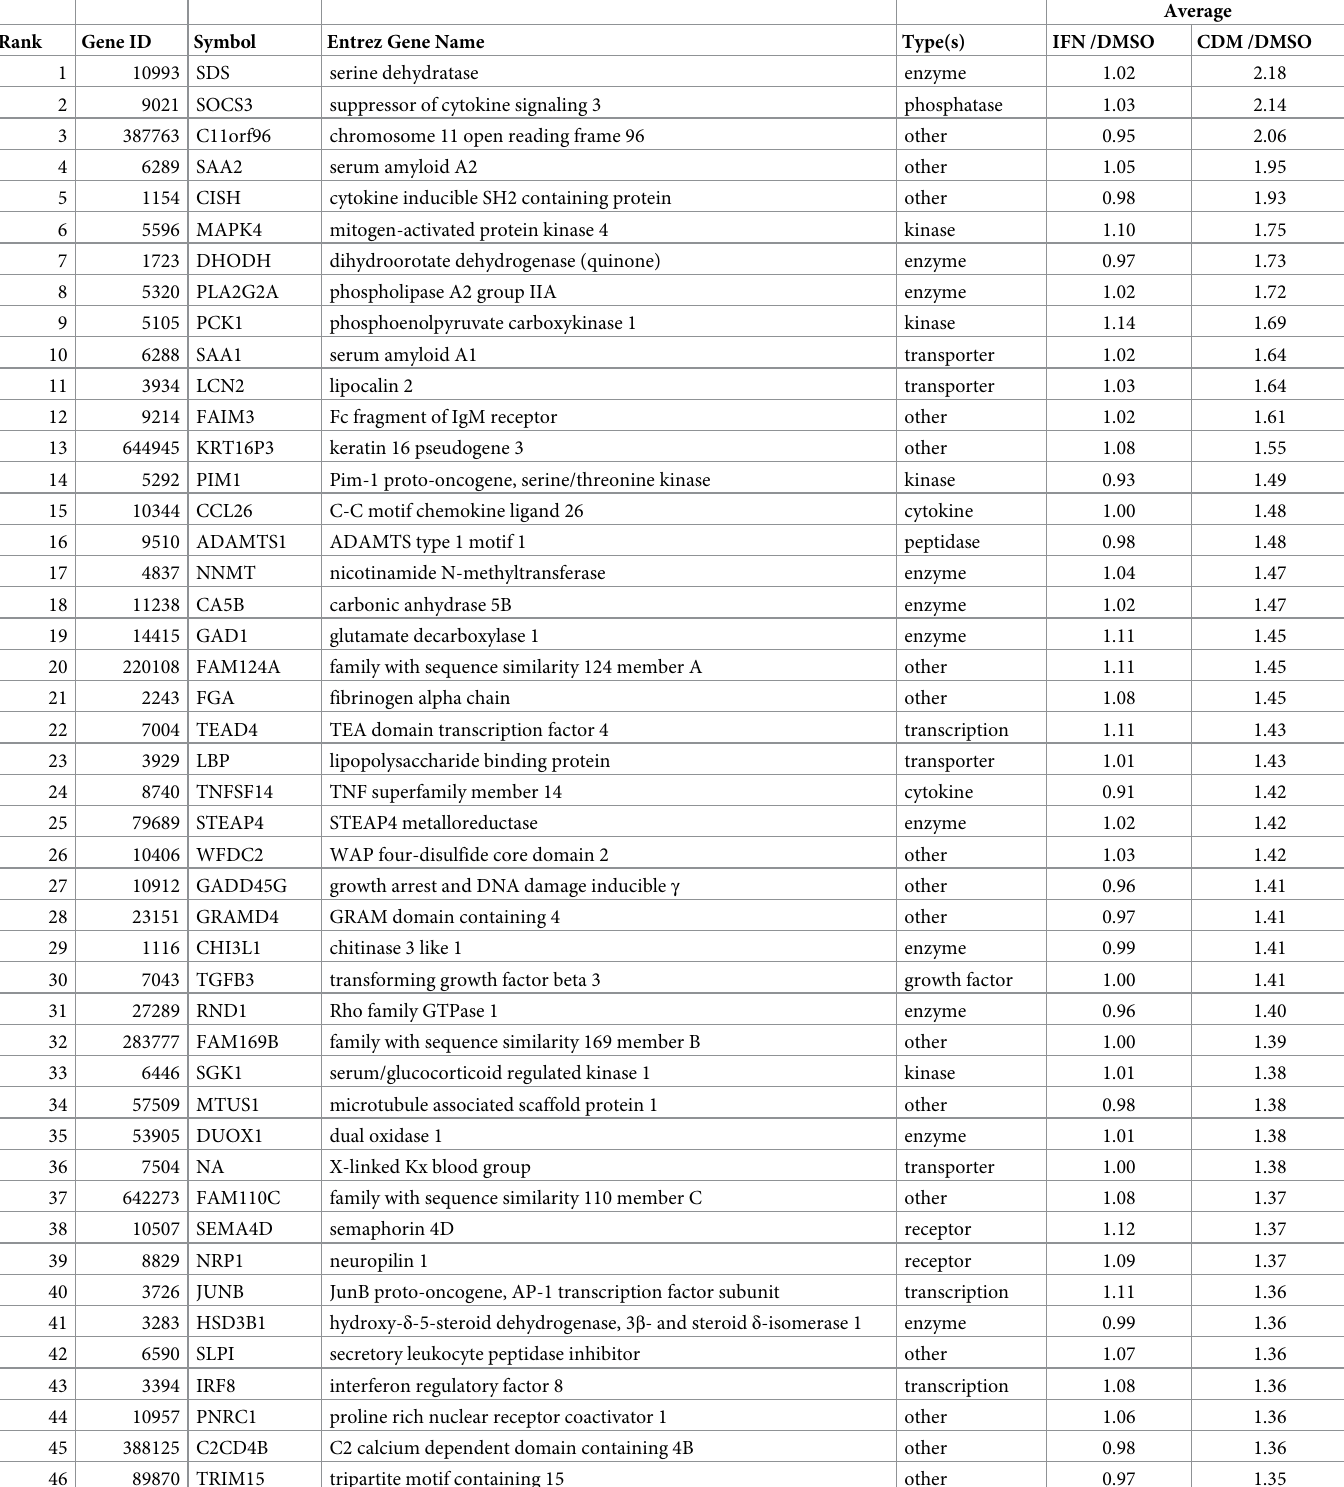
Table 1. Top 50 genes specifically upregulated by CDM-3008 treatment.